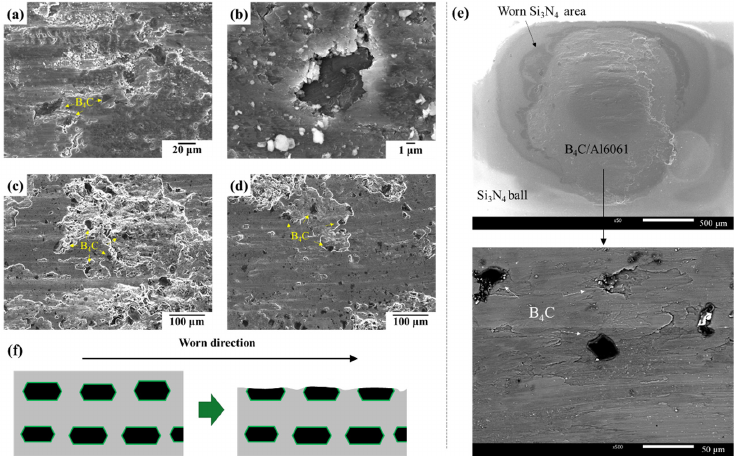
Figure 8. Surface SEM images of 20 vol.% B 4 C/Al6061 composites after wear test at ( a , b ) 5 N and ( c , d ) 20 N, ( e ) SEM images of Si 3 N 4 ball after wear test, ( f ) Schematic of wear mechanism of B 4 C/Al6061 composite .